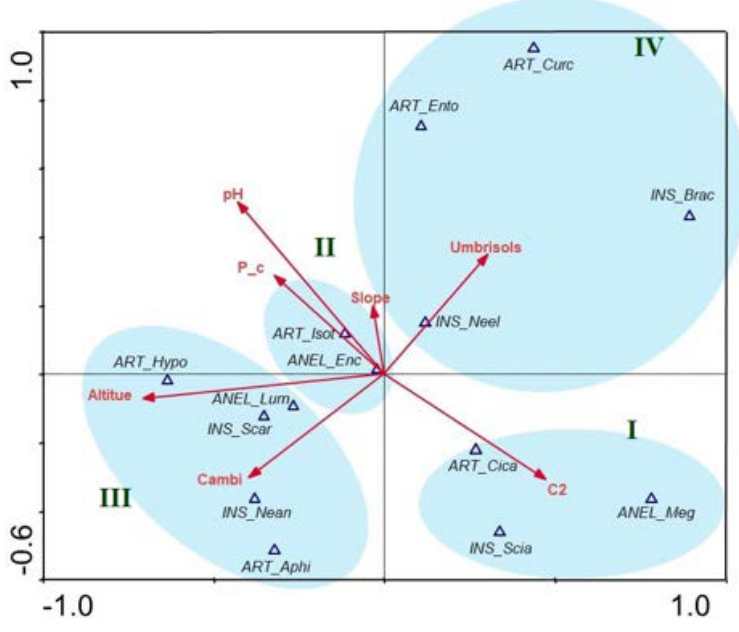
Figure 5. Biplot of grassland environmental features and soil communities resulting from CCA analysis (environmental features are indicated in red, soil communities are indicated in black with a blue triangle, and blue circles with the Roman numeral indicate clusters). The suffixes ART, ANEL, and INS refer to the targets—Arthropods, annelids, and insects.